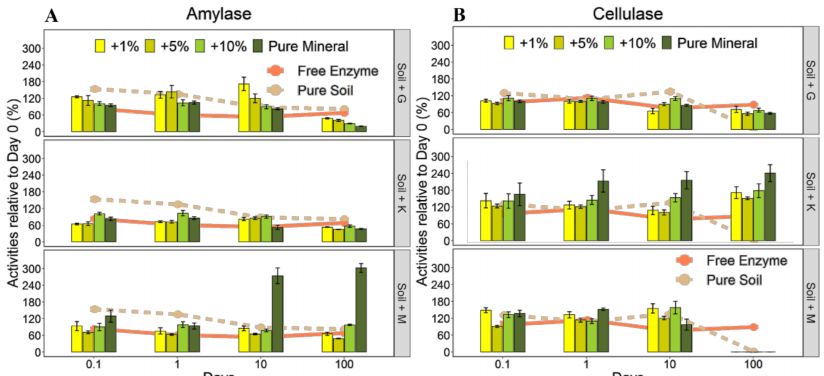
Figure 4. Persistence of activities of amylase ( A ) and cellulase ( B ) relative to the initial activities (at day 0) of each treatment with montmorillonite (M), kaolinite (K), and goethite (G) addition and the pure minerals. Error bars are ± standard error (SE) of means; n = 4. Lines represent the persistence of activities for free enzyme and in the pure